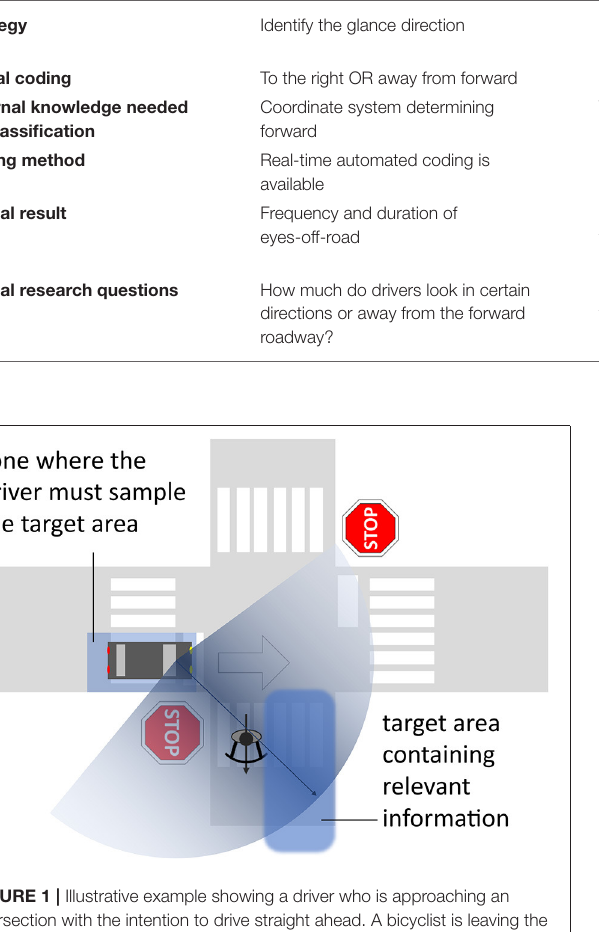
FIGURE 1 | Illustrative example showing a driver who is approaching an intersection with the intention to drive straight ahead. A bicyclist is leaving the intersection. While in the zone with a good view of the intersection, before entering it, the driver is looking right (thin arrow—foveal vision, shaded sector—peripheral vision), checking for traffic potentially present in the target area. A similar check for traffic from the left is required, too (but not illustrated in the